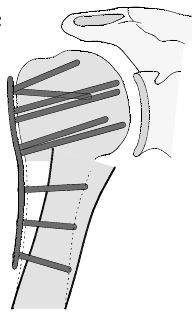
Figure 17. Complication Type 3. Pattern image. The displacement of the humeral shaft after angle- stable plate osteosynthesis is shown by the transition of the dashed drawing (initially correct humeral shaft position) to the prominent black drawing.